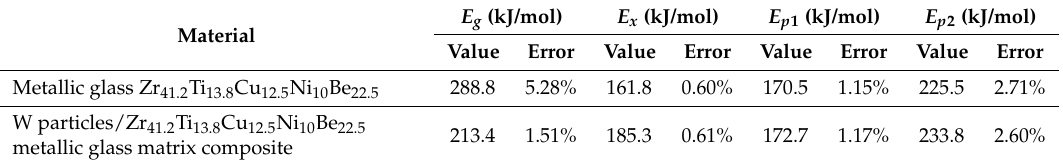
Table 2. E g , E x , and E p of the metallic glass Zr 41.2 Ti 13.8 Cu 12.5 Ni 10 Be 22.5 and the